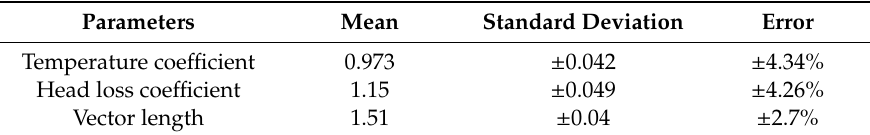
Table 4. Statistics of the sensitivity